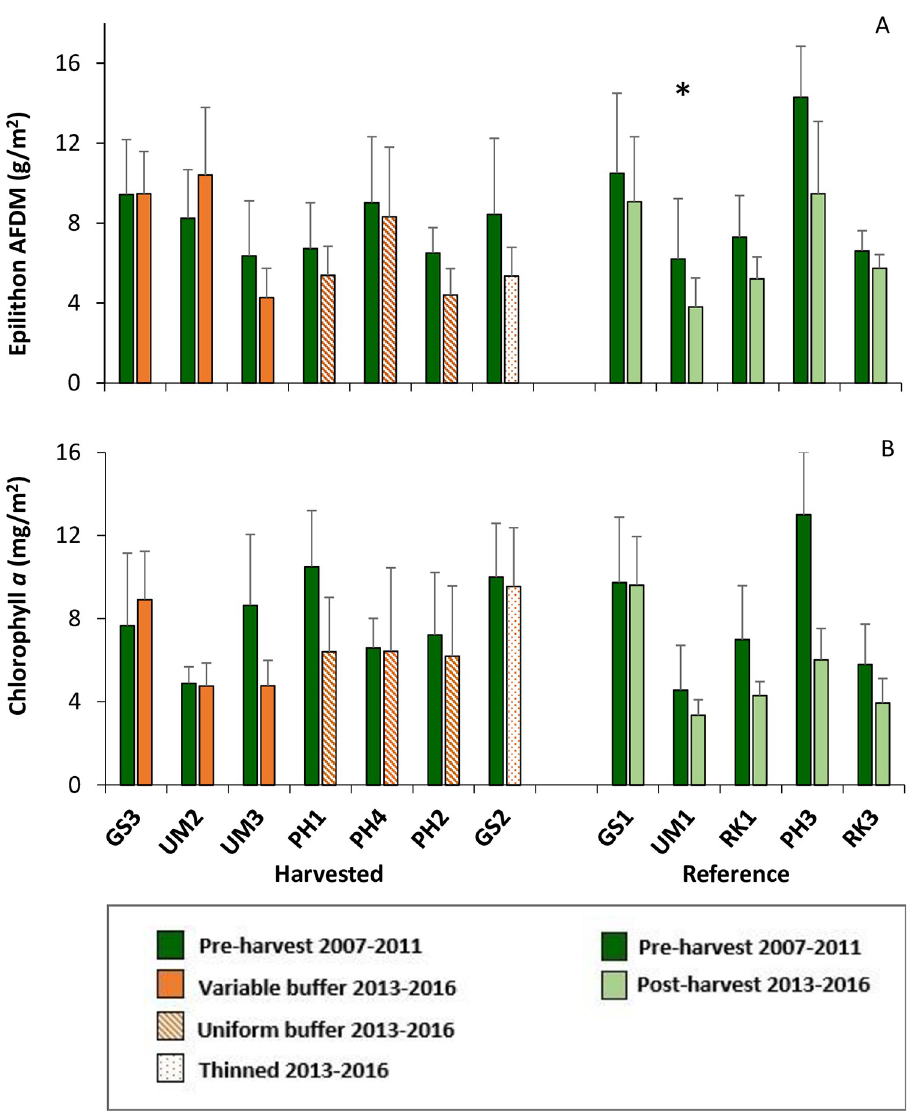
Fig 6. Average epilithon biomass and chlorophyll a concentration at headwater sites. Sites are organized from left to right by percentage of overstory light reaching the stream post-harvest. A) Average epilithon biomass as ash free dry mass (AFDM) plus standard deviation; B) Average chlorophyll a concentration plus standard deviation. Samples were collected annually in early summer. Asterisks indicate which watersheds showed significant differences between pre- and post-harvest periods using PLS analyses (Table